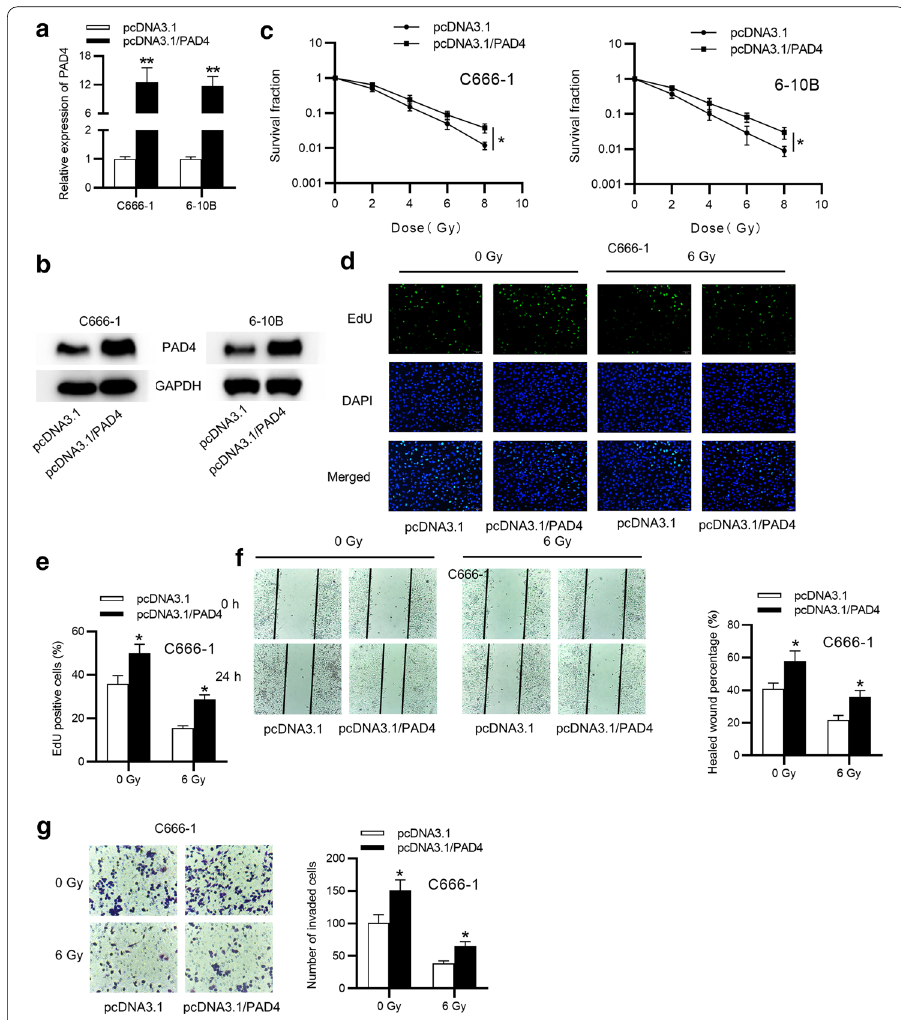
Fig. 2 PAD4 overexpression promotes the radioresistance and cellular processes in NPC. a , b The PAD4 level in NPC cells transfected with pcDNA3.1/PAD4 by RT-qPCR and western blot. c Colony formation assay for cell survival under different doses of radiation. d , e Cell proliferation in NPC cells transfected pcDNA3.1/PAD4 by EdU assay, at 24 h after 6 Gy irradiation. f , g Migration and invasion in NPC cells transfected pcDNA3.1/PAD4 by wound healing and Transwell, at 24 h after 6 Gy irradiation. Unpaired Student’s test. *p < 0.05, **p <